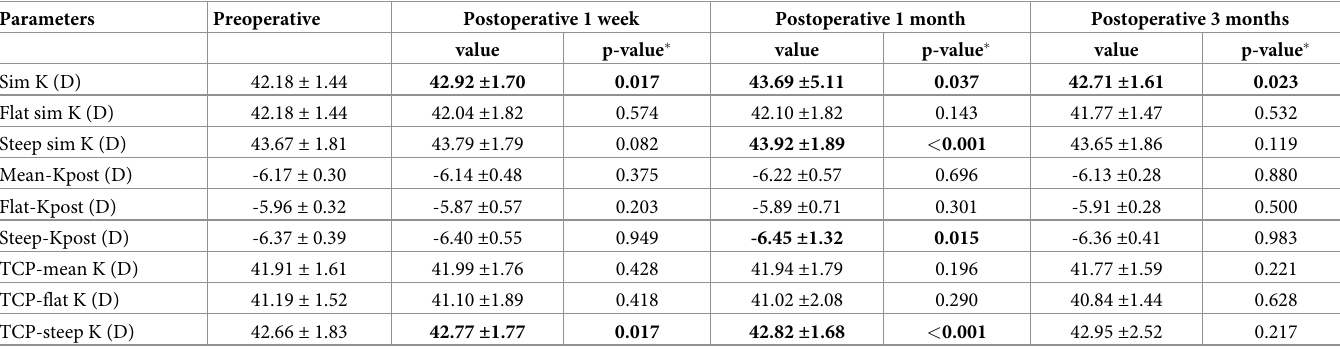
Table 3. Comparison of preoperative and postoperative data on corneal structure in group